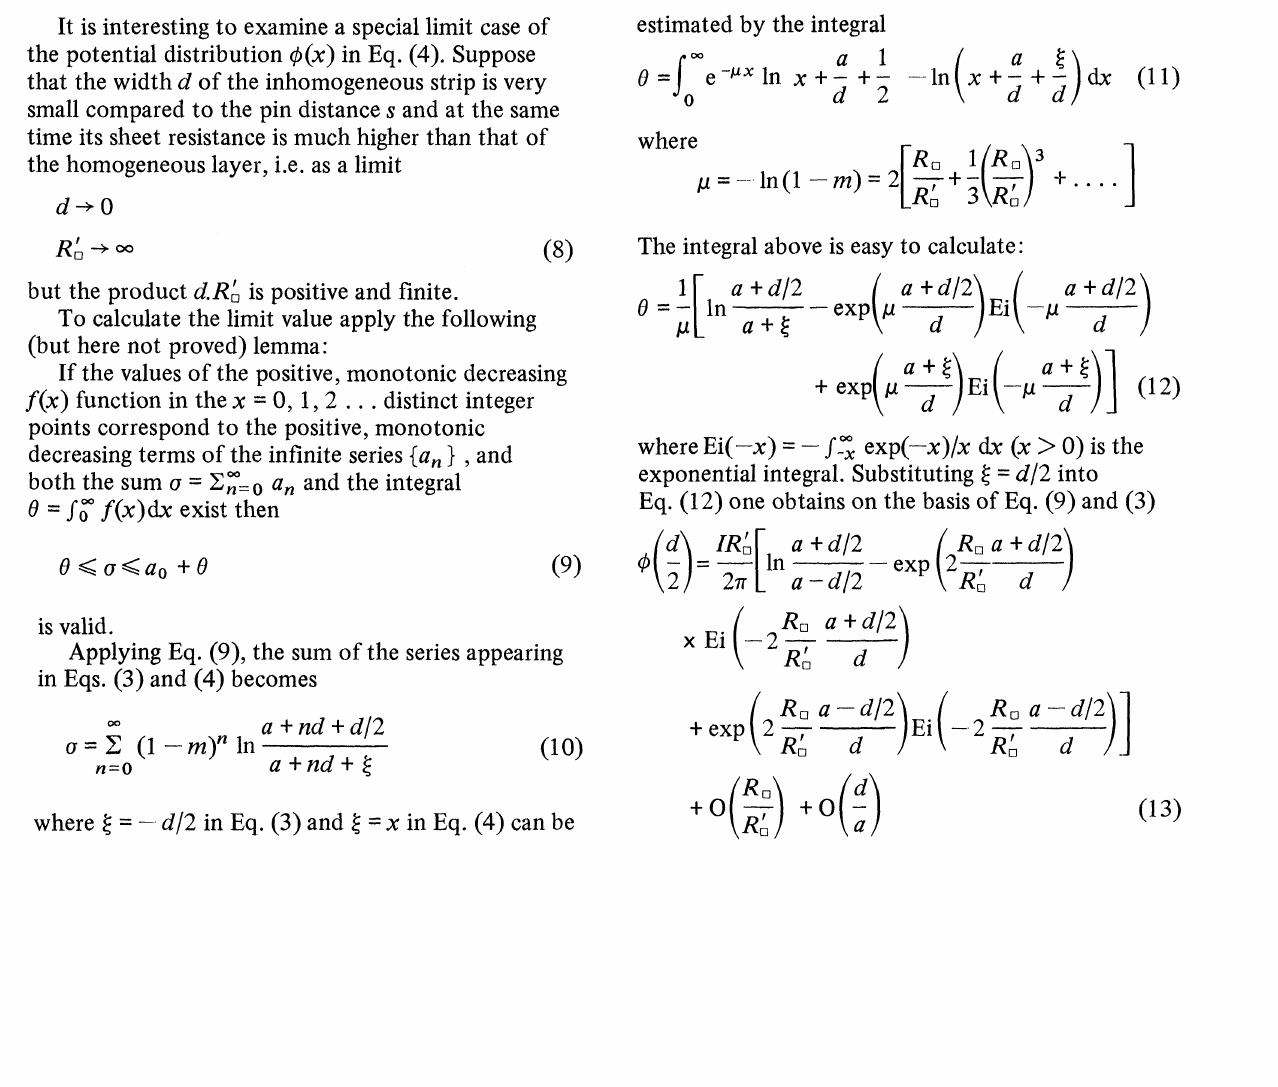
FIGURE 3 Diagrams for evaluation of sheet resistance of a